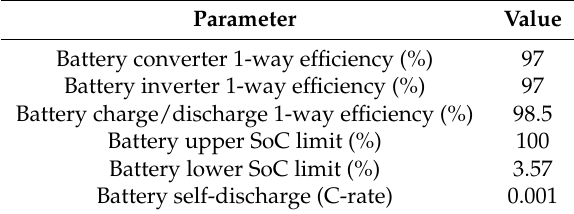
Table A1. Parameters used for the battery in the PV-battery simulation.